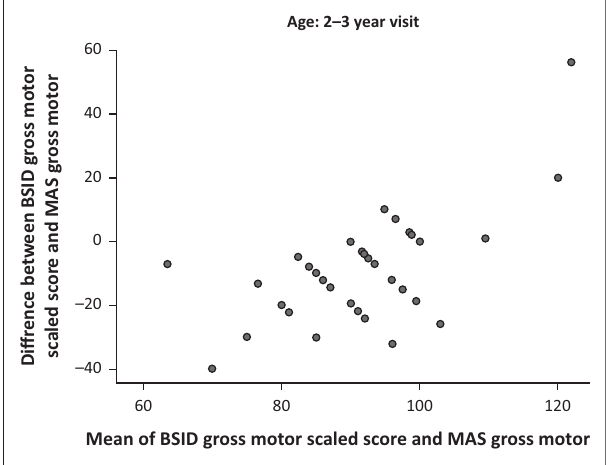
FIG URE 2: Bland–Altman scatter plot illustrating mean difference between Molteno Adapted Scale and Bayley Scales of Infant and Toddler Development- 3rd edition language scores versus Molteno Adapted Scales and Bayley Scales of Infant Development-3rd edition language scores at the 2–3-year visit.